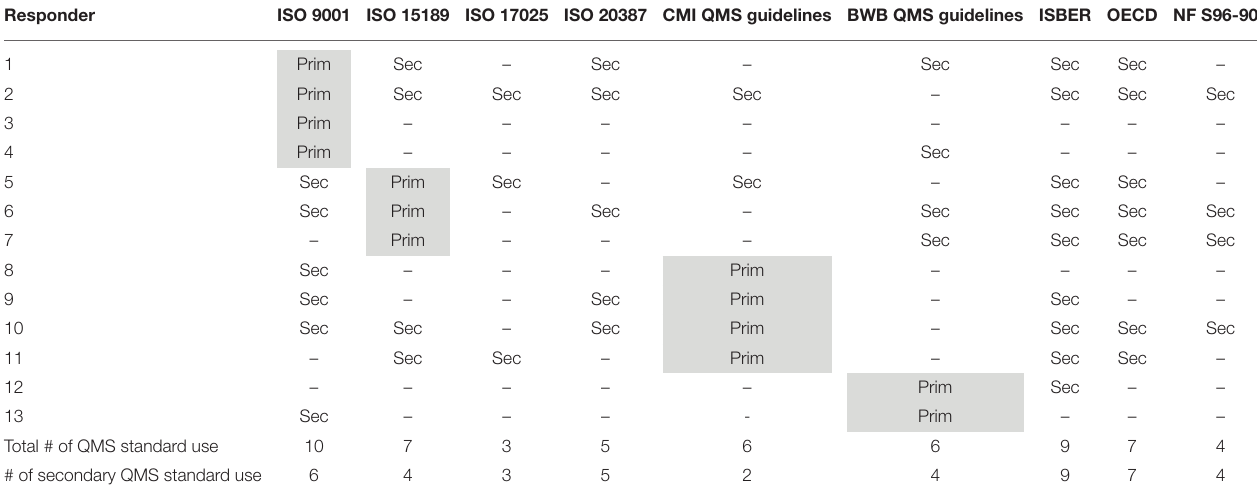
Prim, standard/guideline used as primary basis for QMS; Sec, standard/guideline used as supplementary basis for QMS; QMS, Quality Management System.